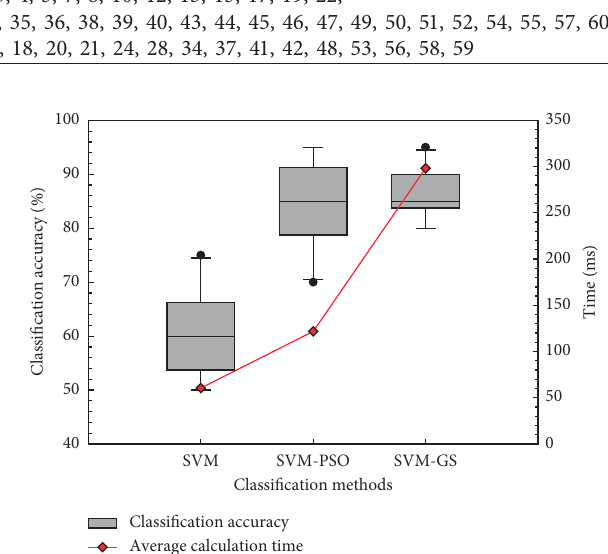
Figure 11: Classification results of SVM, SVM-PSO, and SVM-GS.